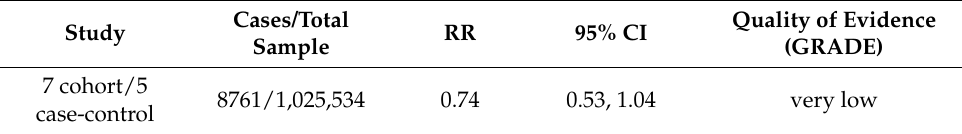
Table 2. Summary of GRADE